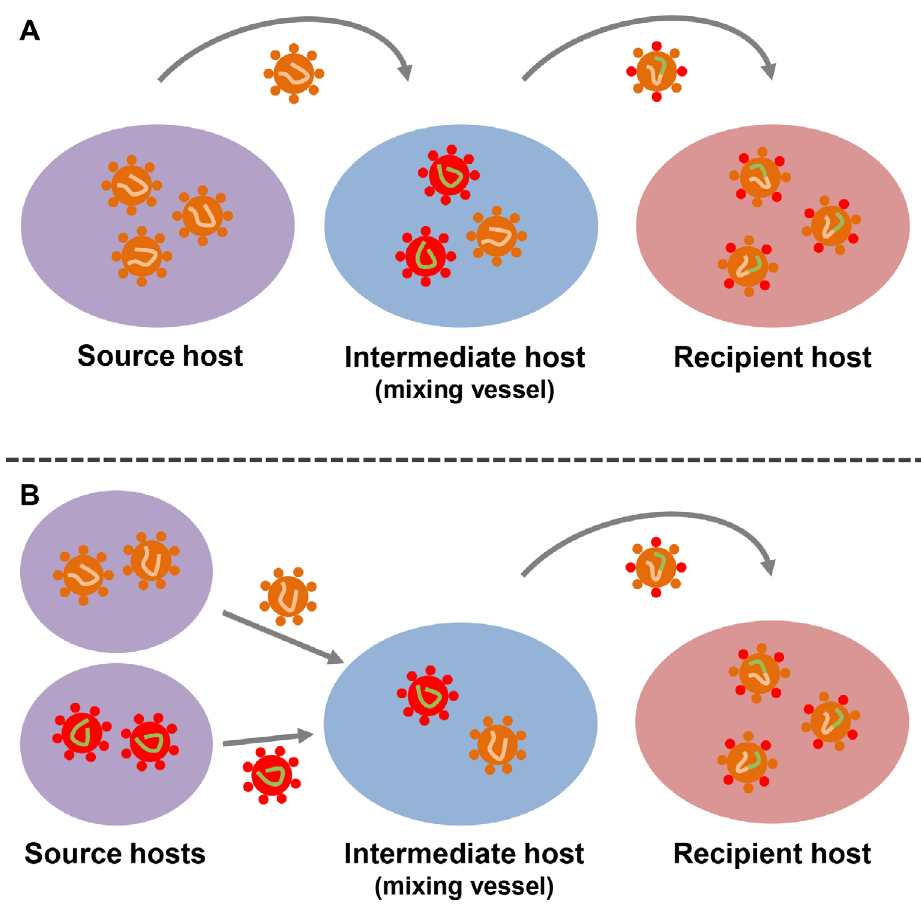
Figure 3 – Intermediate host as a “mixing vessel” for the emergence of new viral strains. When an intermediate vertebrate host is infected by different viral strains, recombination or reassortment can occur between viral species, generating new viral strains. The intermediate host can function as a mixing vessel of new viral trains in two ways. A: a viral strain from a source host exchanges genetic information with a viral strain originally present in the intermediate host, producing a new viral strain. B: the intermediate host is infected with viral strain from two (or more) source hosts, allowing the exchange of genetic information between the viral species, producing a new viral strain. Hypothetical viral recombination in an intermediate host is exemplified in this figure, but the same processes can be applied to viral